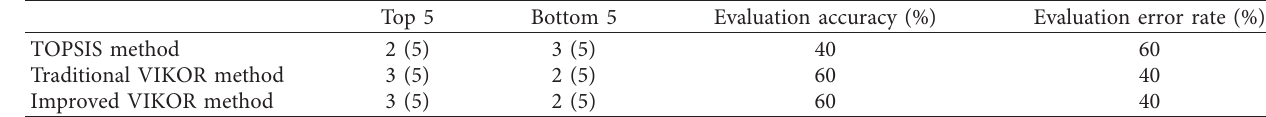
Table 7: Effectiveness test of 2016 evaluation